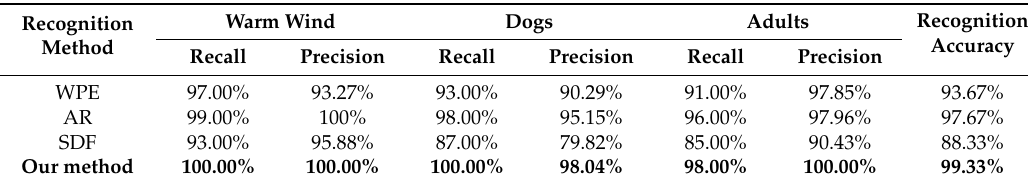
Table 5. Recall, precision and the overall recognition accuracy of each method in the comparative experiments on Database 1.